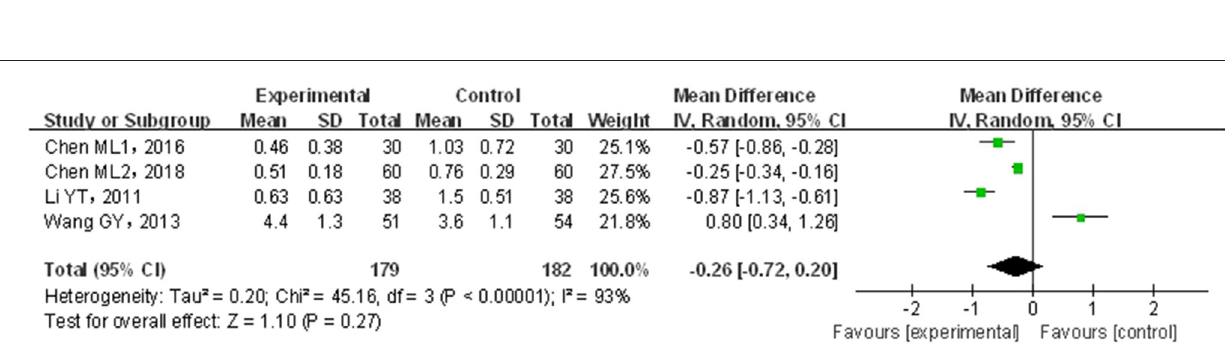
FIGURE 5 | Meta-analysis of infant massage and drug therapy in the treatment of children with functional constipation to reduce stool form scores.